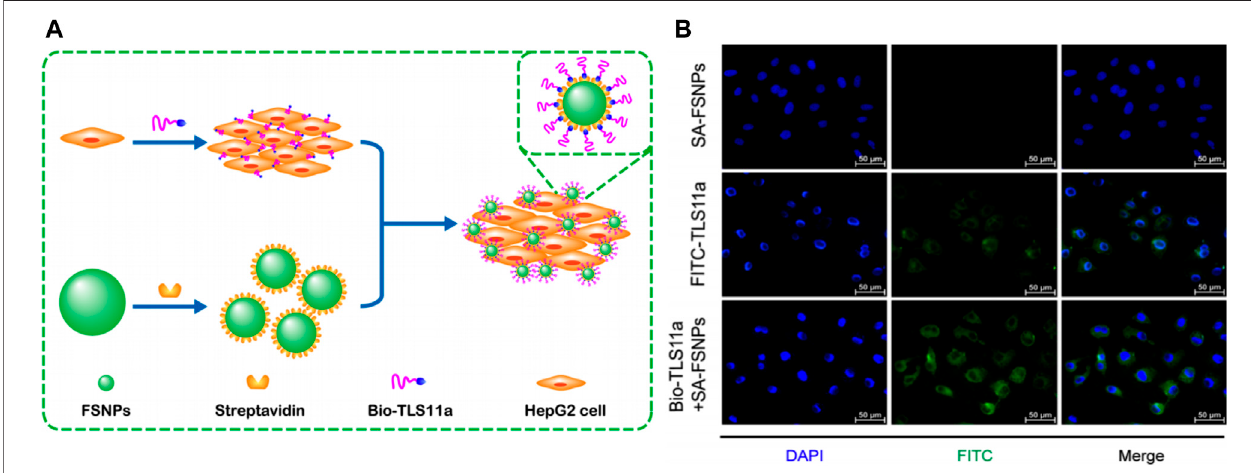
FIGURE 5 | (A) Schematic illustration of highly sensitive detection of HepG 2 hepatoma cells using a biotin-conjugated aptamer (Bio-TLS11a) and streptavidin- conjugated fl uorescent silica nanoparticles (FSNPs). (B) Fluorescence micrographs of HepG 2 cells after incubation with SA-FSNPs or FITC-TLS11a or the combination of both. Reprinted with permission from Hu et al. (2017). Copyright (2017)